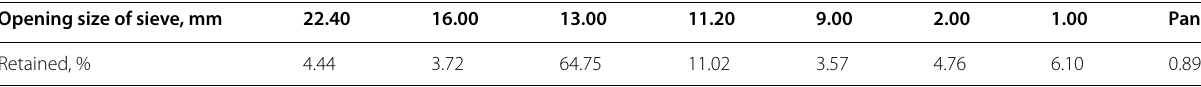
Table 1 Particle size analysis of mushroom residues Opening size of sieve,